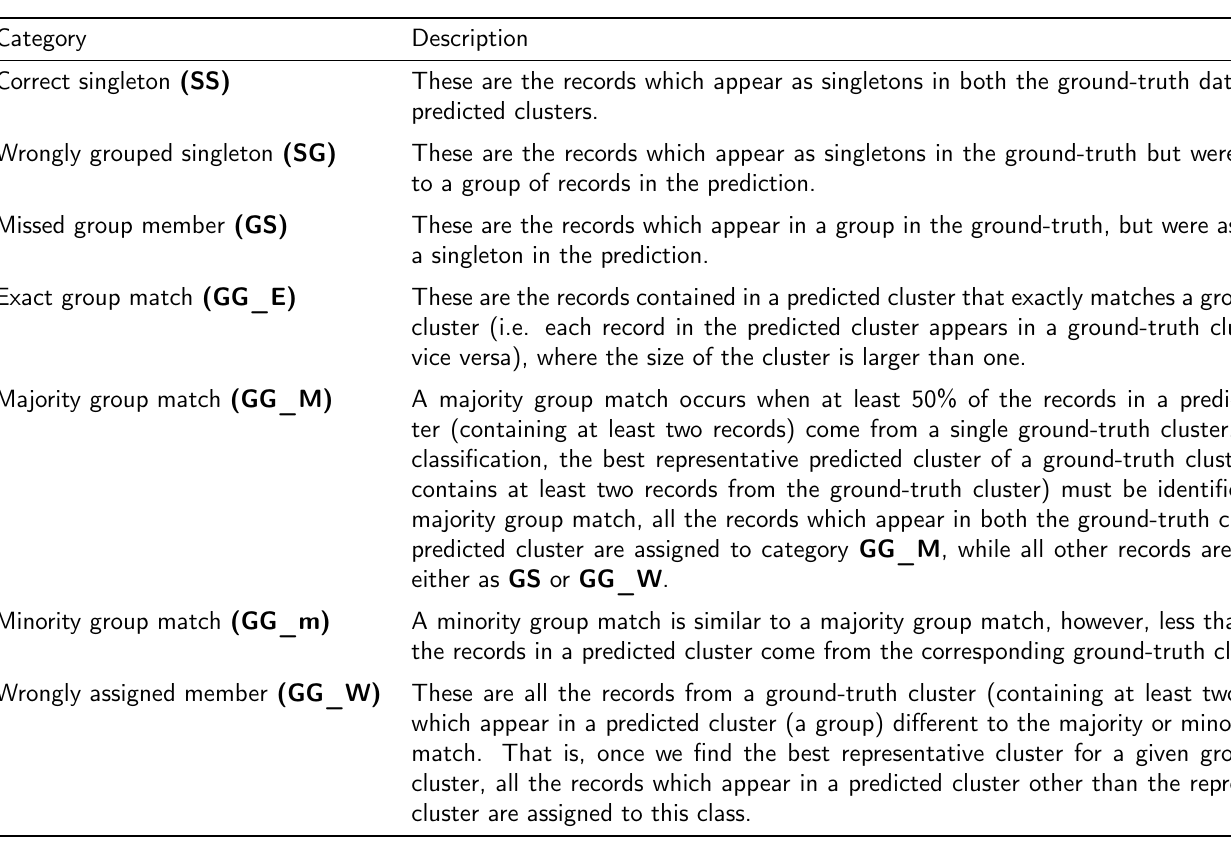
Table 3: Classification of records for evaluation